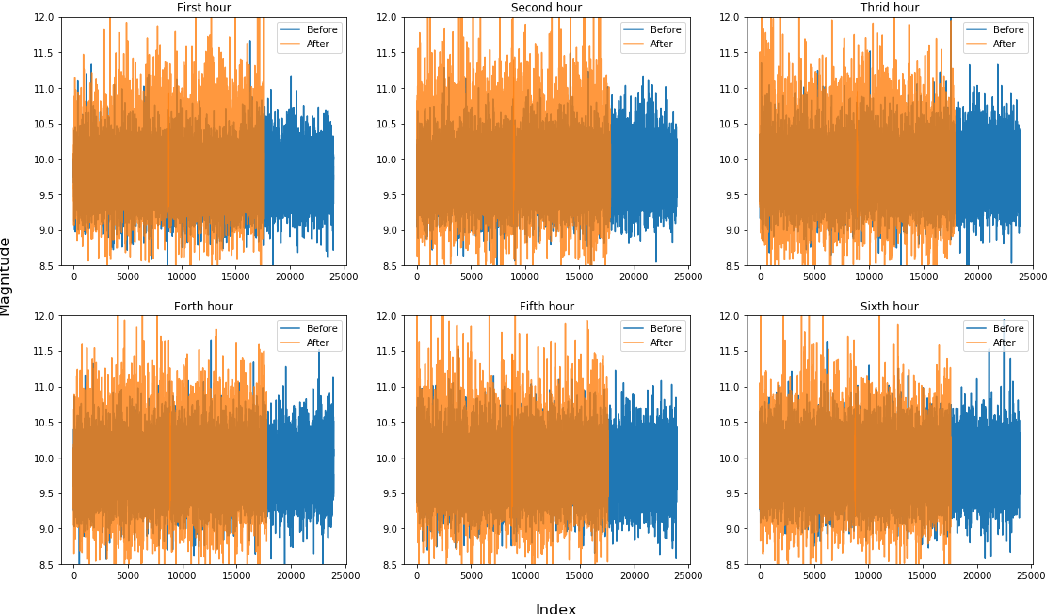
Figure 10. Time domain plot for data collected from inside sensor before and after inserting Red Palm Weevils through